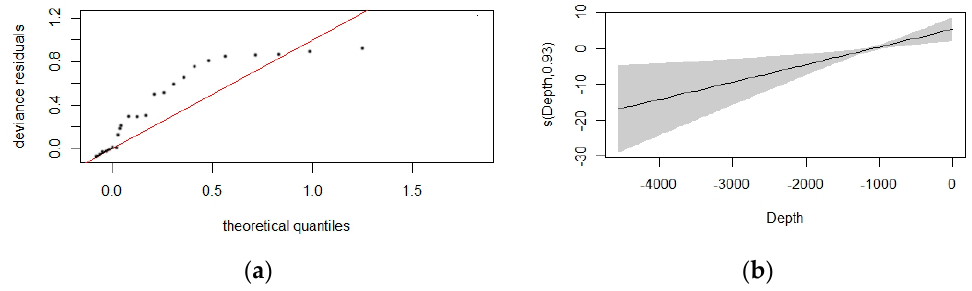
Figure 7. Quantile–quantile plot with negative binomial response distribution and the variables latitude, longitude, and depth ( a ). Smooth function is for depth ( b ). Grey shading corresponds to 95% confidence levels, and the numbers in brackets on the vertical axis labels give the e ff ective degrees of freedom of the